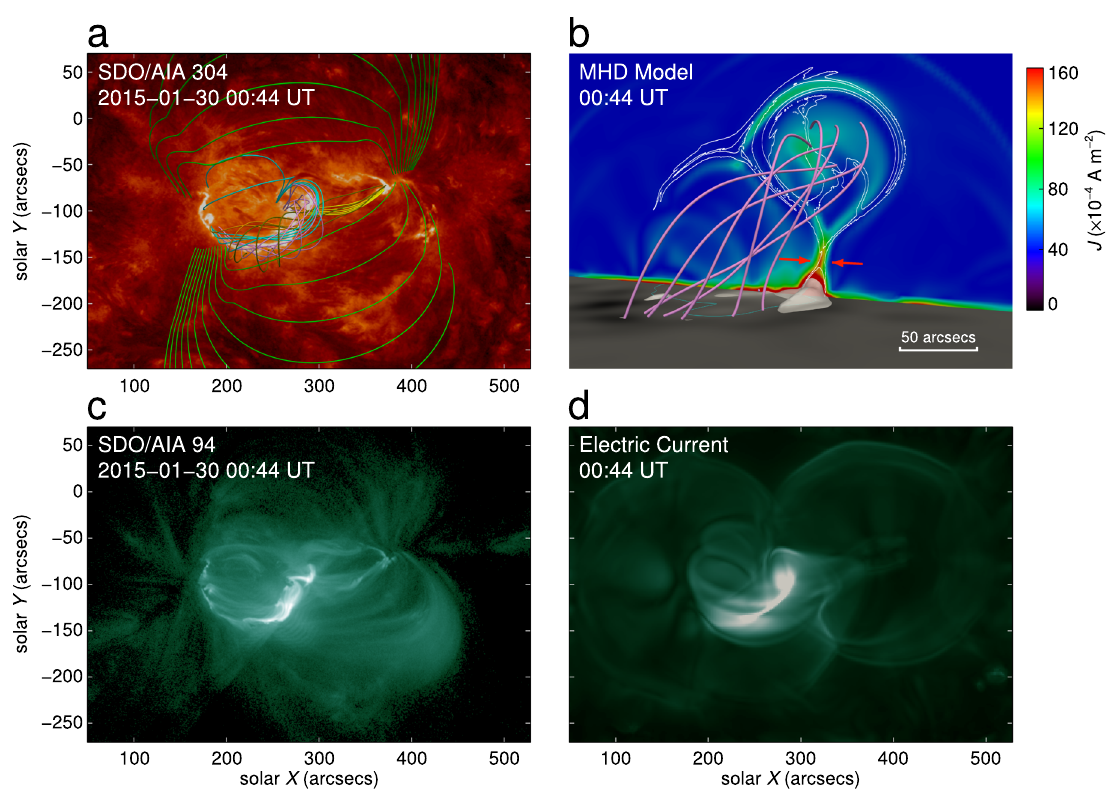
Fig. 6 Comparison between MHD simulations and AIA extreme-ultraviolet observations at the peak time of the M2.0 fl are. a Selected magnetic fi eld lines overlaid on an AIA 304 Å image from the vertical perspective. The fi eld lines in green are located at a relatively high altitude. The pink and olive lines have the same meaning as that in Fig. 4. The cyan, yellow and orange lines have the same meaning as that in Fig. 2b. b The MFR from a side view. The fi eld lines in pink are the same as that in panel a . The vertical slice perpendicular to the MFR axis displays the electric current density overlaid by the contour of the QSLs with log ð Q Þ > 3. The two red arrows indicate the in fl ow at the reconnection site. The white semi-transparent isosurface represents the electric current density larger than 32.9% of the maximum value in the whole domain. The bottom surface shows the distribution of the vertical magnetic fi eld component, B z , overlaid by the polarity inversion line in cyan. c AIA 94 Å image at 00:44 UT on 30 January 2015. d Synthetic emission at 94 Å calculated by the integration of the electric current density along the vertical direction at the peak